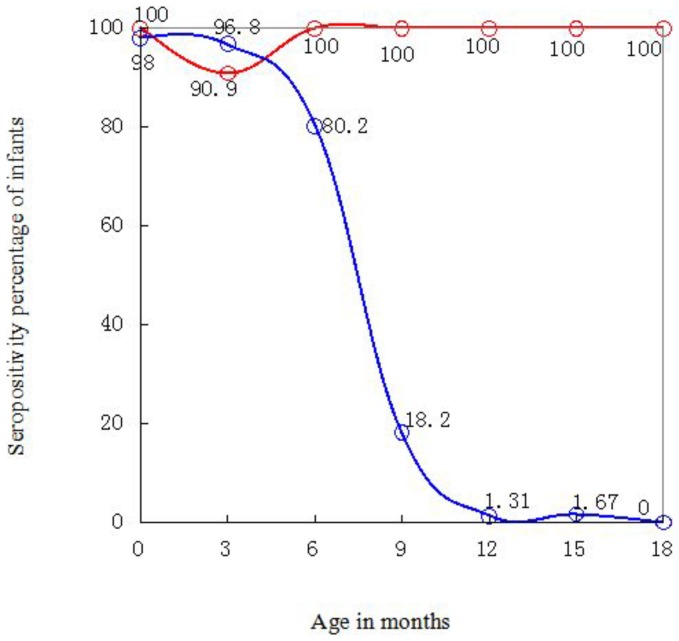
HIV sero-status of infants.Red and blue lines indicate infected and uninfected infants, respectively. Calculations were based on 943 DBSs from 256 uninfected infants and 82 DBSs from 24 infected infants. At each month of age, sample sizes of infected babies were all ≥11 except at 9 months of age with 6 samples; sample sizes of uninfected babies were all ≥93.